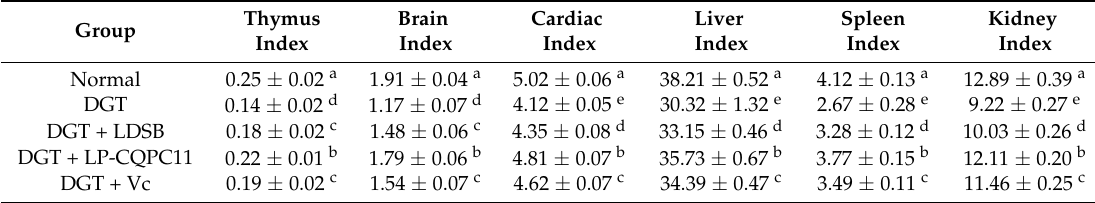
Table 1. Organ index of mice in each group ( n = 10).